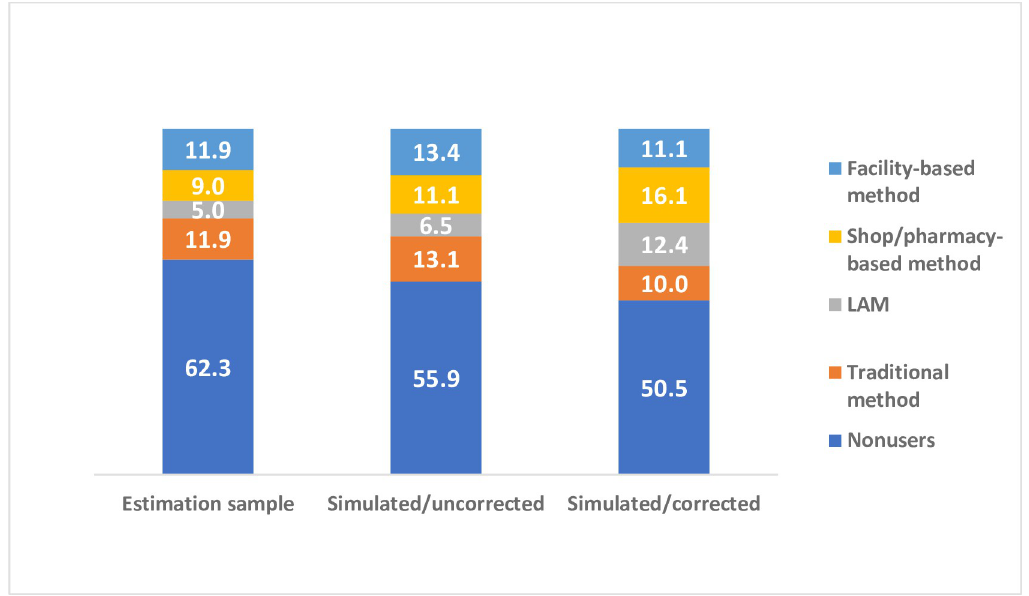
Fig 1. Postpartum method choice (%) in estimation sample and in simulated samples (uncorrected and corrected).